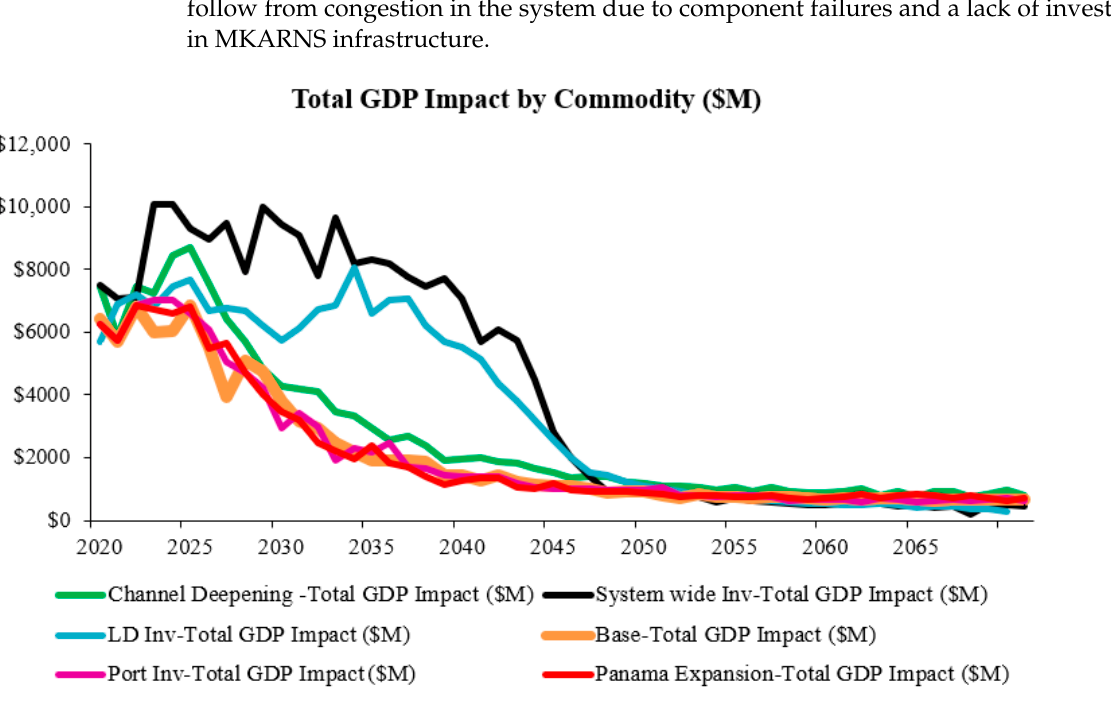
Figure 5. Comparison of the impacts on GDP in the scenarios, by commodity.